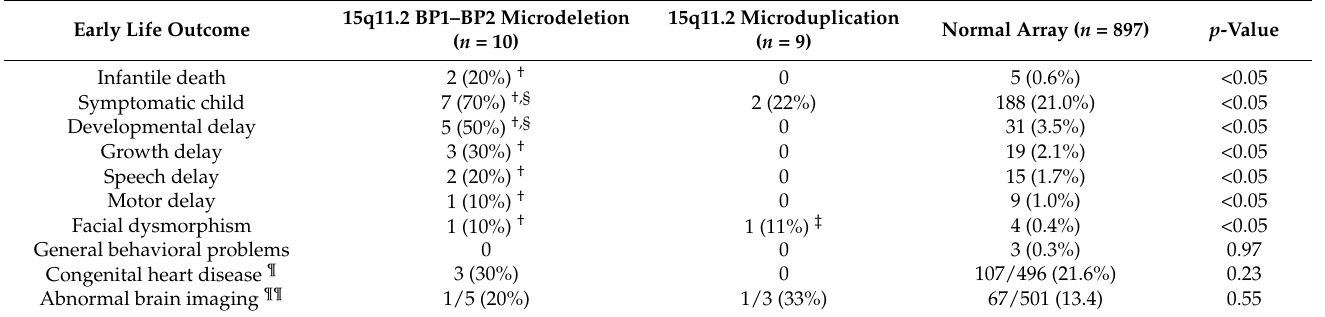
Table 6. Early life outcomes of the children between the 15q11.2 CNV groups and the normal array group. Early Life